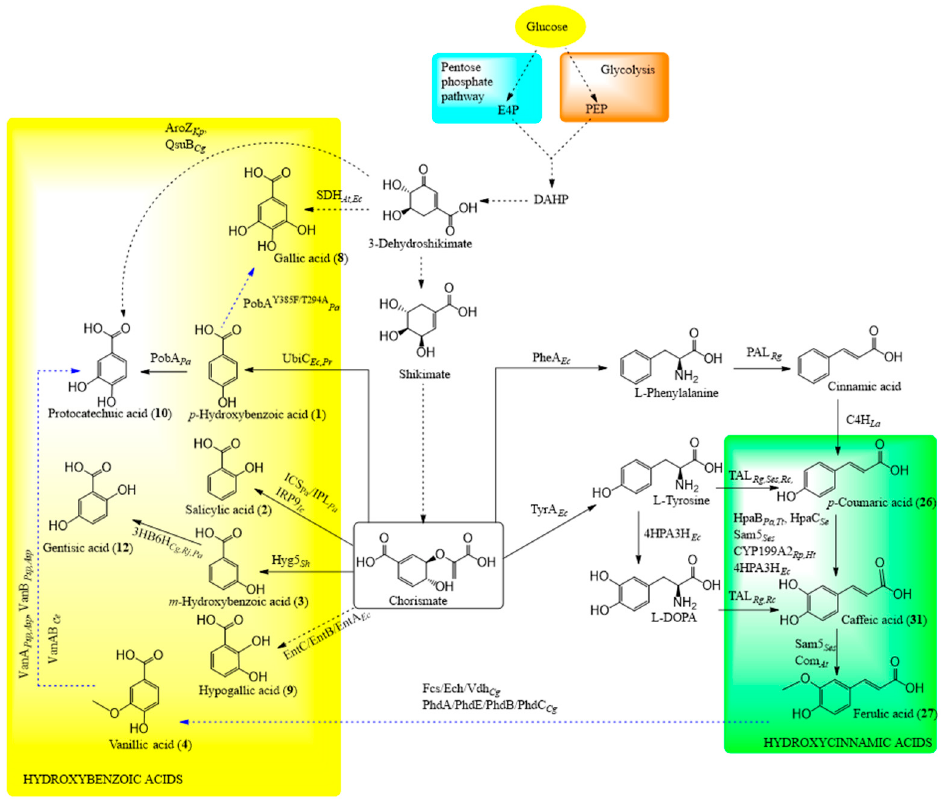
Figure 2. General pathways for the biosynthesis of phenolic acids by the engineered microorganisms. Solid arrows indicate the direct conversion, and the dotted arrows indicate the conversion through two or more reactions. Black arrows show phenolic acid production from glucose while blue arrows indicate their production from precursors. Abbreviations: aroZ, dehydroshikimate dehydratase; C3H, 4-coumarate 3-hydroxylase; C4H, trans-cinnamic acid 4-hydroxylase; COMT5, caffeic acid 3- O - methyltransferase; CYP199A2, cytochrome p450 CYP199A2; 3,5-DHS, 3,5-dehydroshikimate; 3-DHS,